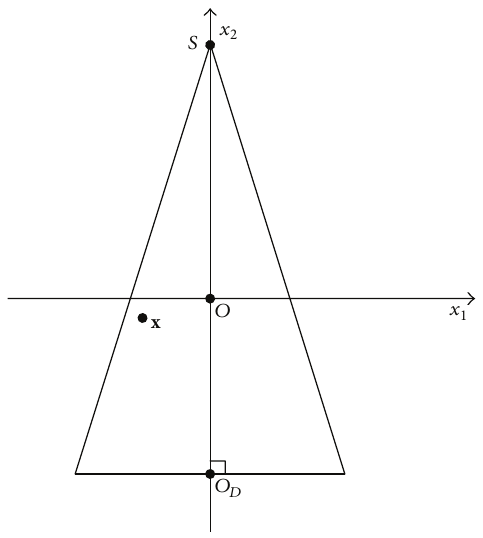
Figure 1: A simple geometric relationship of an equal-spaced fan beam.